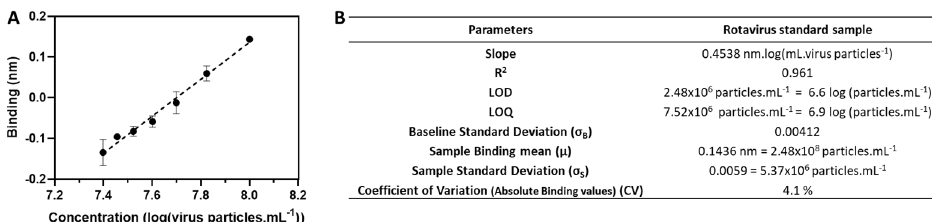
Figure 2. Calibration curve for rotavirus particles binding to anti-VP7 monoclonal antibodies. Error bars represent the standard deviation (representative of n = 3) ( A ). Qualification assay parameters for rotavirus particles based on the response level at equilibrium. Inter-assay precision (for absolute binding values), reported as CV%, was evaluated using a reference standard loaded in three independent runs ( B ).